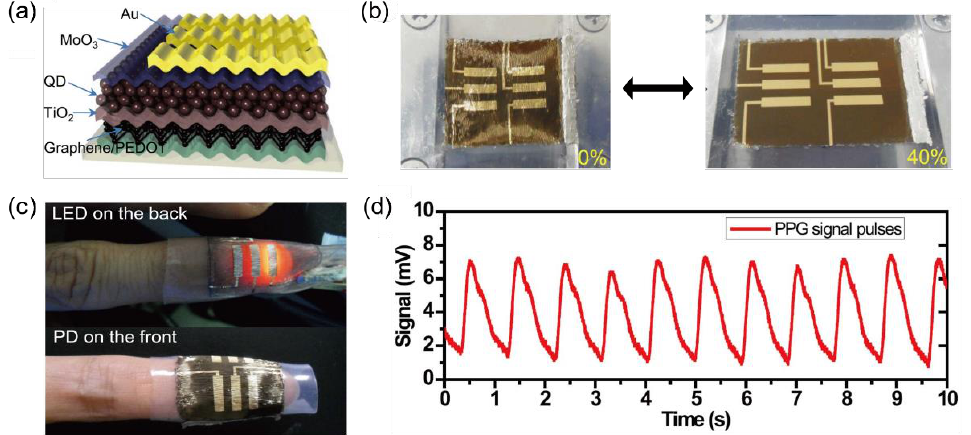
Figure 8. ( a ) Cross-sectional view of structure of the stretchable PbS QD photodetector excluding the elastomer substrate. ( b ) Optical image of the stretchable QD photodetector from 0% to 40% strain. ( c ) Image of working QD-LED and QD photodiode on the fingertip. ( d ) Records PPG pulses collected in real time under red QD-LED conditions. Adapted with permission from [34], ACS Publications, 2017.